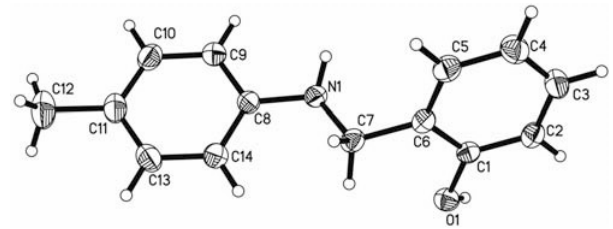
Table 1. Data collection and handling.